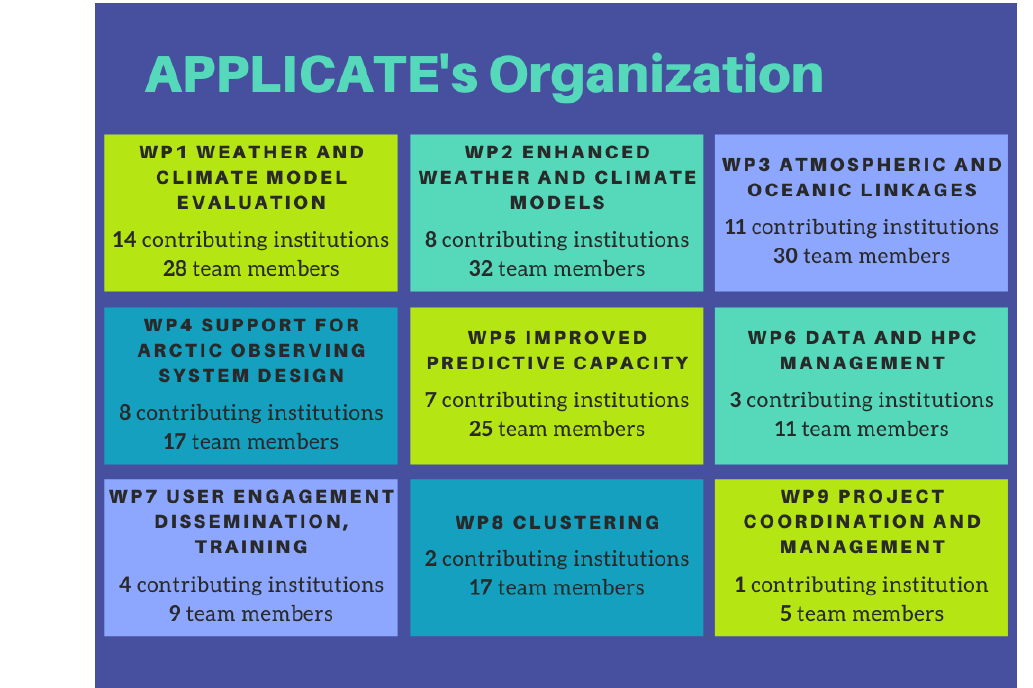
Figure 1. Summary of APPLICATE’s work packages, their working topics, and their composition.